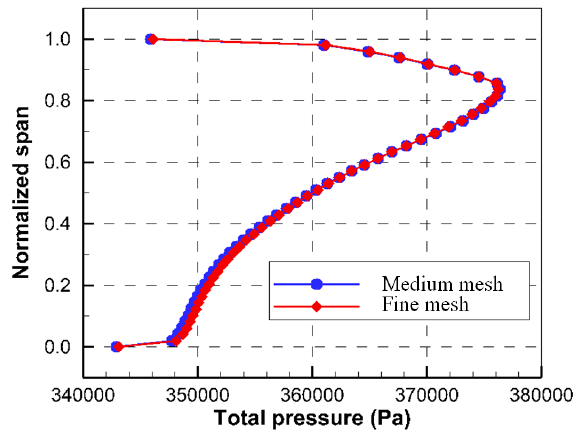
Figure 4. Grid sensitivity analysis for the mass averaged total pressure at compressor exit along its span.